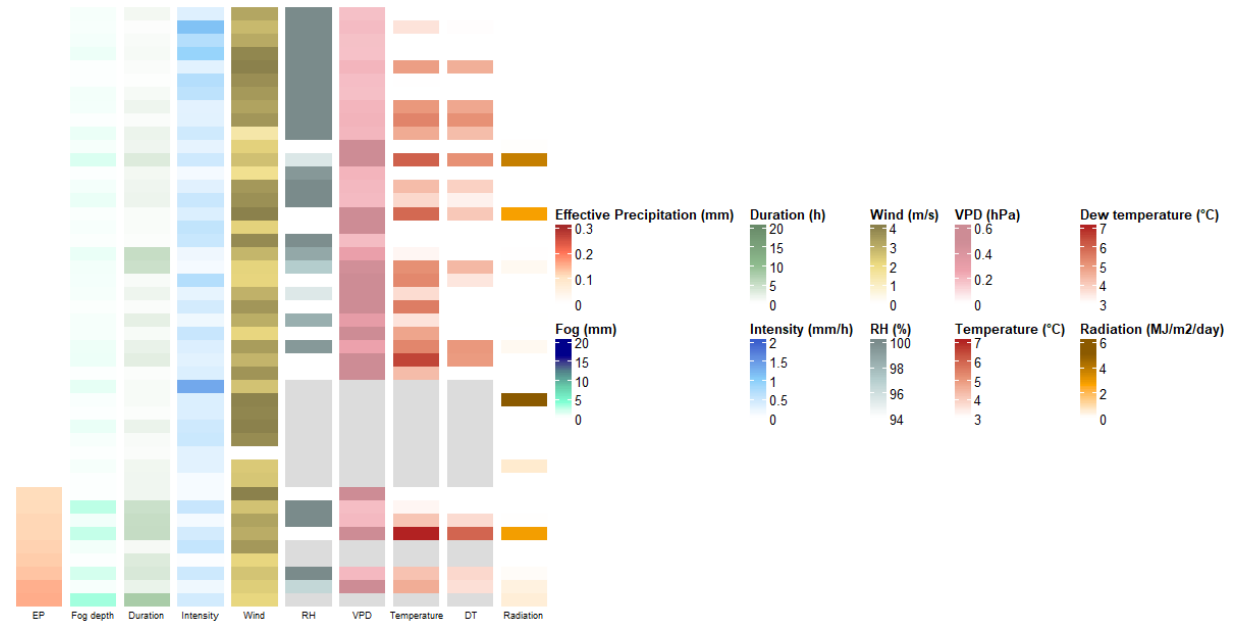
Figure A1. Heat-map for fog-only events as they relate to effective precipitation, the event characteristics, and the meteorological variables (wind, relative humidity, vapor pressure deficit, temperature, dew temperature, and radiation) analyzed to find an influence on soil moisture gain. Each bar represents a FO event and they are organized by effective precipitation increasing values.